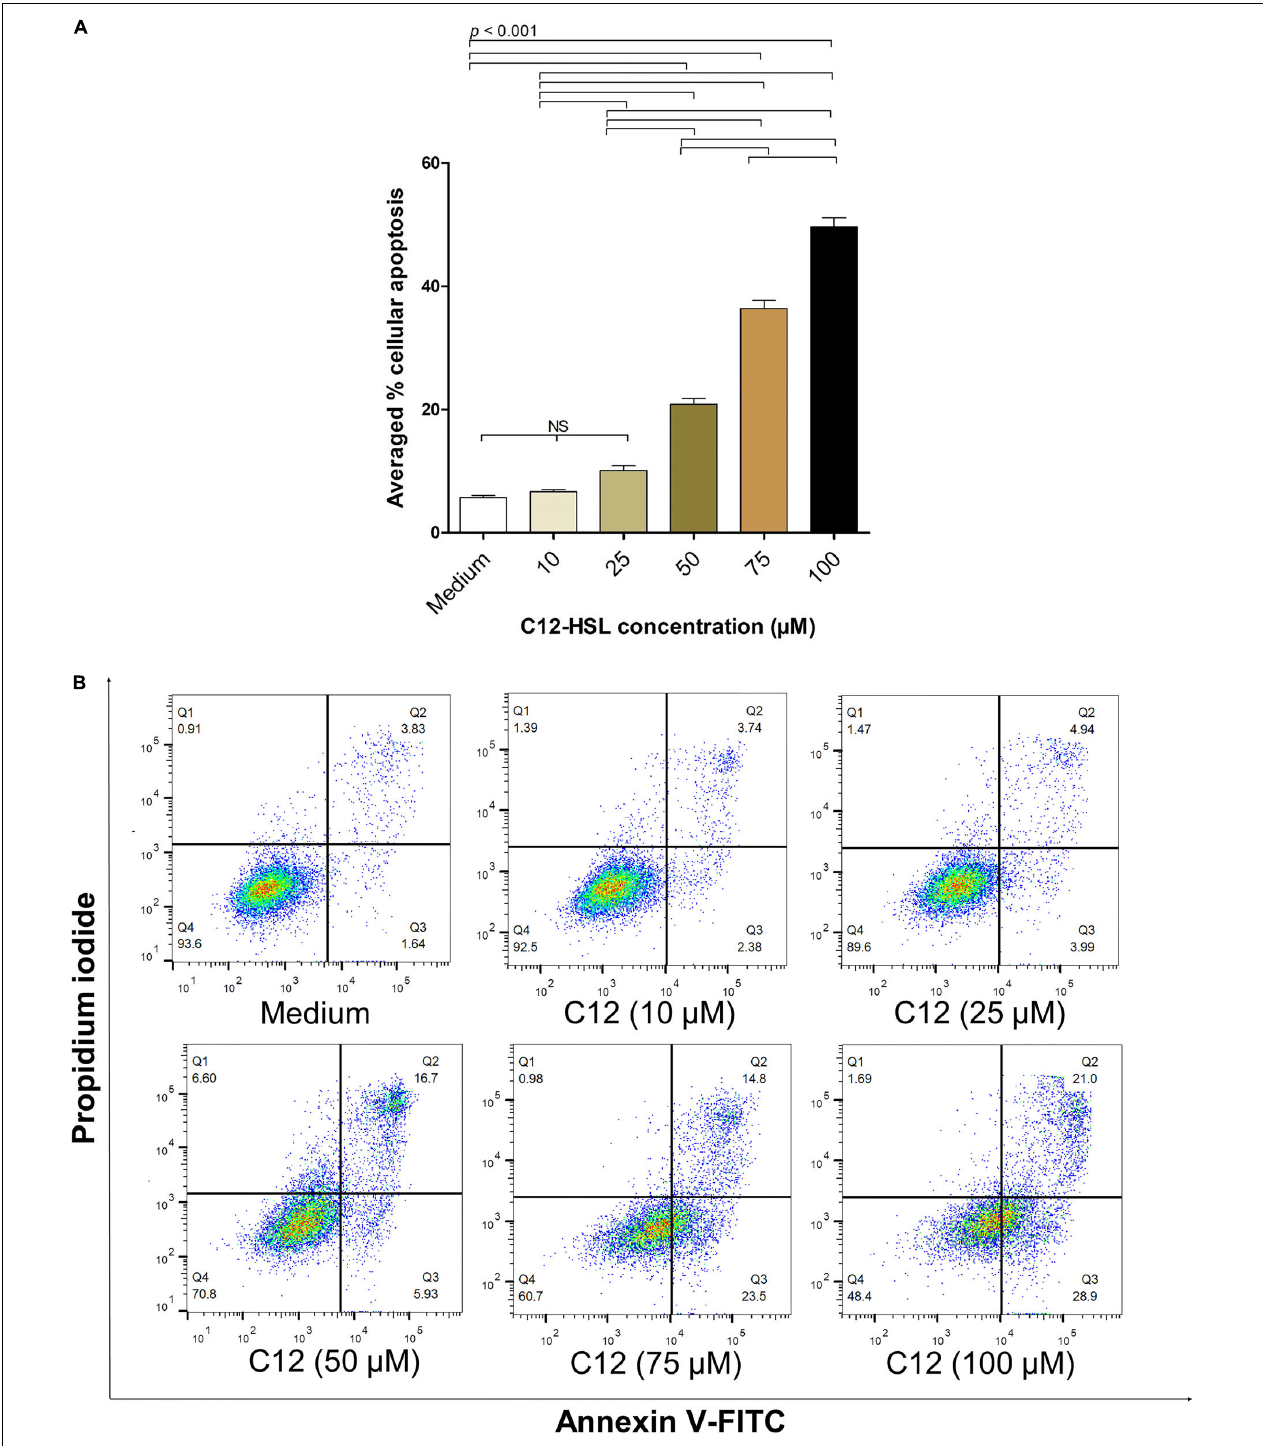
FIGURE 4 | The percentages of apoptotic HeLa cells exposed to different concentrations of 3O-C12-HSL. (A) Bar graph of average percentages (means ± SD) of apoptotic cells from three independent experiments after exposure to 10, 25, 50, 75, and 100 µ M of C12-HSL, compared with the cells in medium alone. (B) The density plots of HeLa cells after treatment with 10, 25, 50, 75, and 100 µ M of C12-HSL, and control cells stained by Annexin V-FITC/PI and subjected to flow cytometric analysis (representative of three independent experiments). The cytotoxic activity of the 3O-C12-HSL was dose-dependent. Q1, necrotic cells (Annexin V negative/PI positive); Q2, late apoptotic cells (Annexin V positive/PI positive); Q3, early-apoptotic cells (Annexin V positive/PI negative), and Q4, viable cells (Annexin V negative/PI negative).